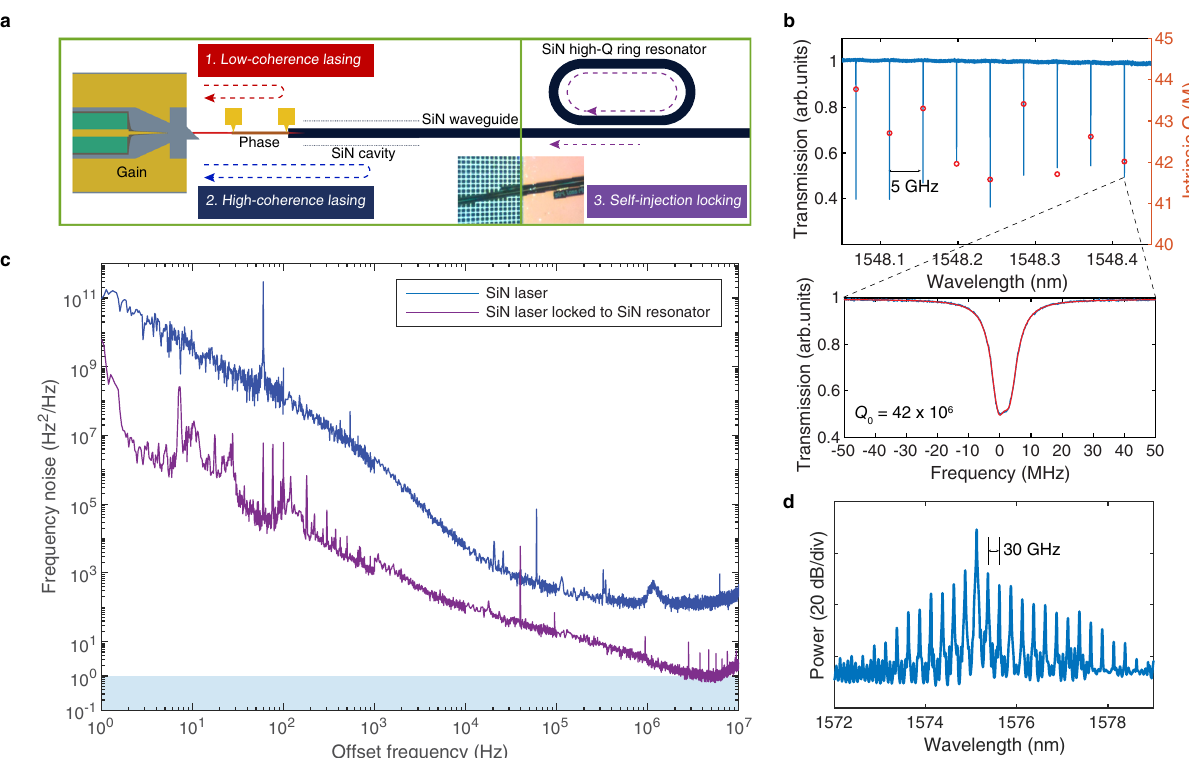
Fig. 3 Heterogeneous SiN lasers self-injection locking to high- Q SiN ring resonators. a Schematic illustration of three potential lasing conditions with a III – V/Si/SiN platform. Each condition relies on different feedback mechanism and results in different laser coherence. b Transmission of a high- Q SiN ring resonator with 5-GHz FSR and the corresponding intrinsic Q factors around the SiN laser resonance. Bottom shows the zoom-in resonance transmission used for self-injection locking with fi tted curve (shown in red). c Laser frequency noise of a high-coherence SiN laser at free-running state (blue) and self- injection-locked state (purple) to a high- Q SiN ring resonator. d Optical spectrum showing frequency comb generation of a high-power laser on III-V/Si/ SiN platform self-injection locked to a 30-GHz FSR high- Q ring resonator with normal